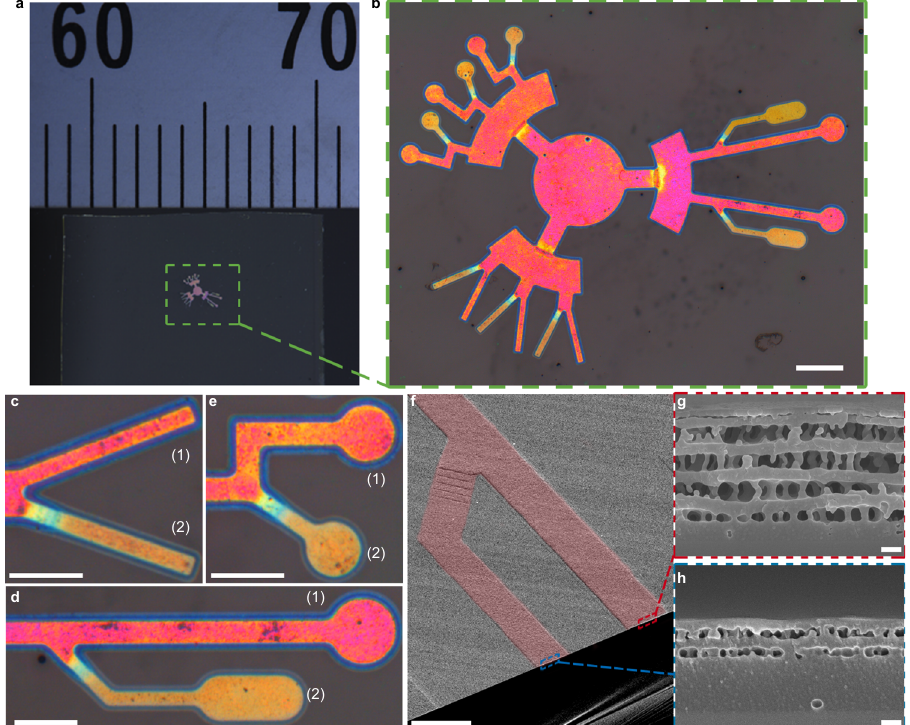
Fig. 5 Manipulation of internal pore size with crosslinking energy. a Photo of OM microchannel made on cover glass. Variation of branch colour is accomplished by changing energy dosage according to the design as speci fi ed in Supplementary Fig. 10: the main channel adopted a high energy dosage while the side branch adopted a low energy dosage. b Microscope photo of the same OM microchannel in ( a ). c – e The corresponding zoom-in microscope photos, where the main channels (labelled as (1), energy dosage: 600 mJ/cm 2 ) show a more reddish structural colour compared to the side branches (labelled as (2), energy dosage: 300 mJ/cm 2 ). f An SEM image for the OM microchannel in ( d ). Red colour is added to highlight the channel. The original image is shown in Supplementary Fig. 12. g The zoom-in SEM cross-section for the main channel in ( f ). h The zoom-in SEM cross-section for the side branch in ( f ). Scale bar, ( b ), 200 μ m, ( c – e ), 100 μ m, ( f ), 50 μ m, ( g , h ), 200